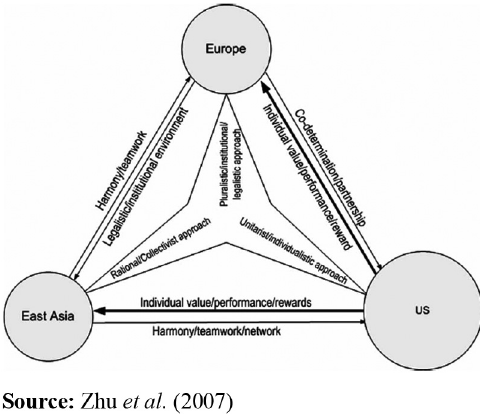
Figure 2. Triangle in fl uence of